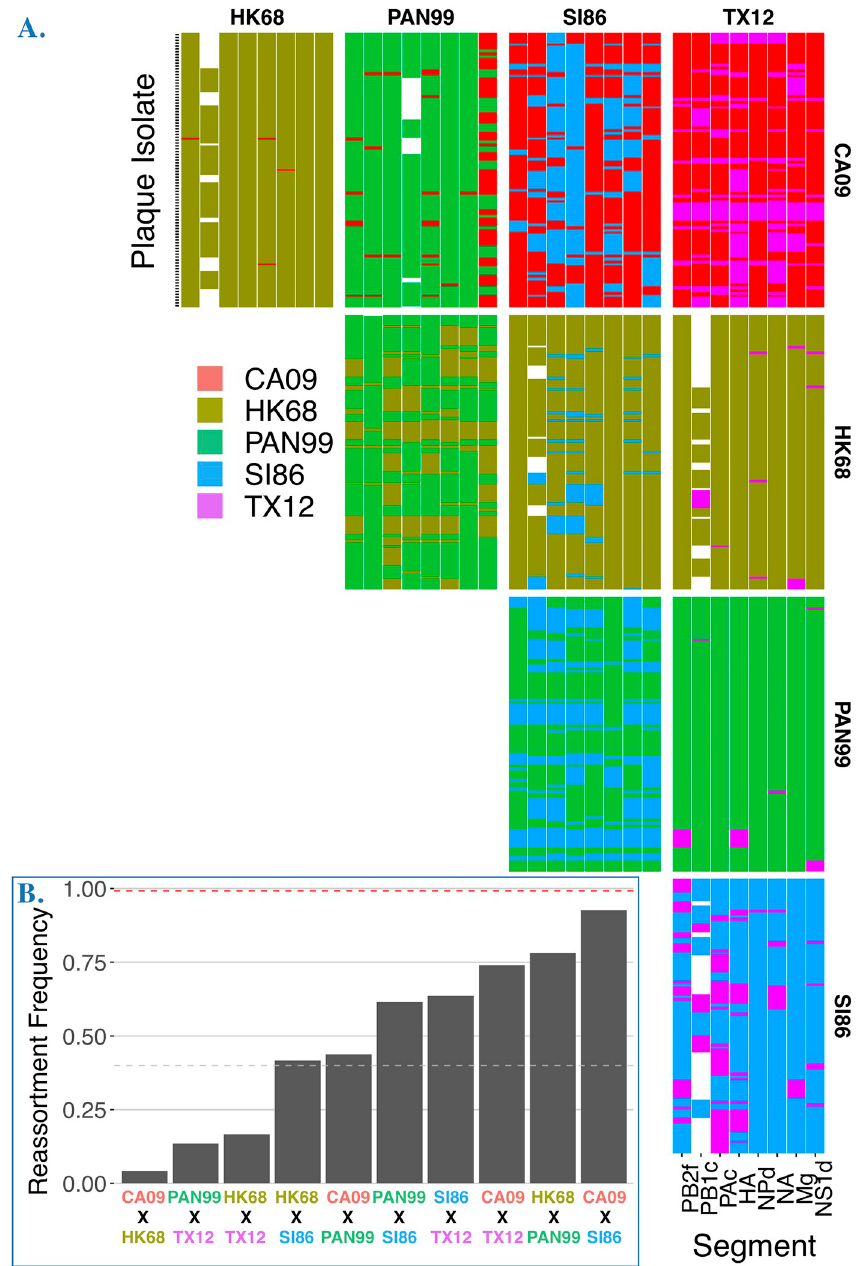
Fig 3. Reassortment plots and rates determined from plaque isolates. A. Reassortment plot of genotyped progeny isolated from each coinfection performed in this study. Genotypes for individual progeny are depicted as rows in each panel with columns indicating the genotype (i.e. parental origin) for each of the eight segments. White spaces show genotypes where one or more segments were not identified or recovered. B. Reassortment frequencies (proportion of reassortant plaque isolates) for each coinfection. Red line indicates theoretical maximum reassortment, gray line indicates 40% reassortant progeny. reassortment frequency between the SI86xTX12 (0.635) and PAN99xSI86 (0.615) coinfections were not statistically different, but both were different from CA09xSI86 (0.927). These differ- ences were not explained by genetic similarity (Adj. R 2 = -0.07118, p = 0.5438; Table 2 ,